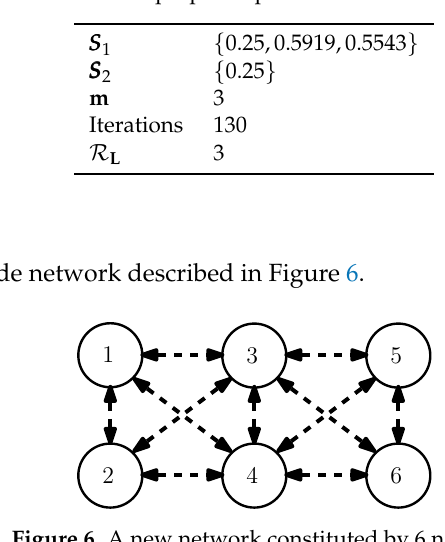
Table 1. The achievement of the proposed procedure in the sense of 4-node topology.